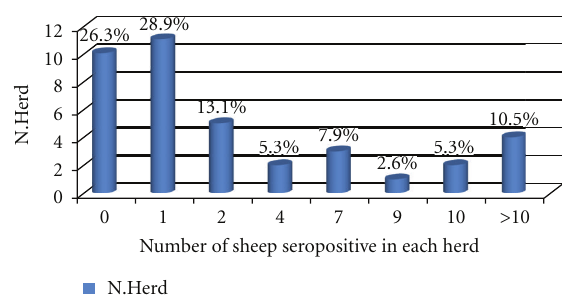
Figure 1: Number and percentage distribution of seropositive sheep over